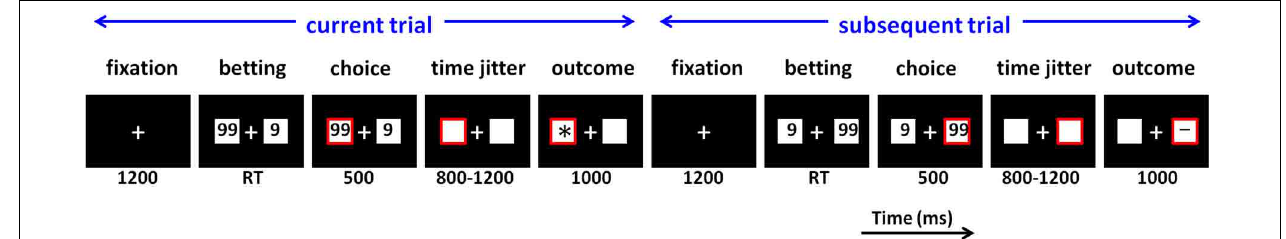
FIGURE 1 | Schematic diagram of two neighboring experimental trials in the monetary gambling task. RT, response time. In this example, the participant chooses “99” in both the current and